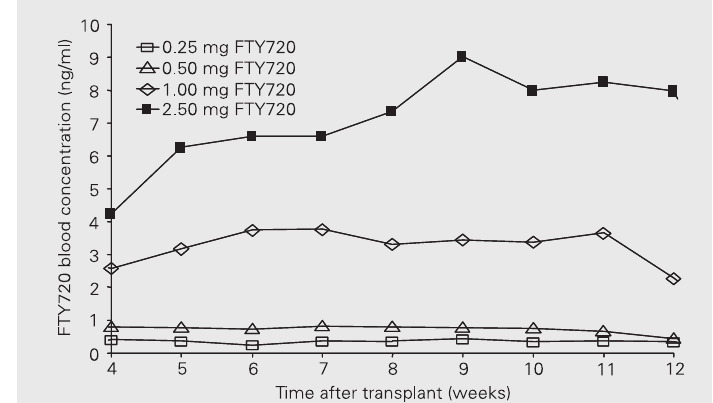
Figure 2. Time course of mean FTY720 blood concentrations between 4 and 12 weeks post-transplant. P < 0.01 for 1.0 and 2.5 mg FTY720 compared to 0.25 and 0.5 mg FTY720 during administration time (ANOVA).